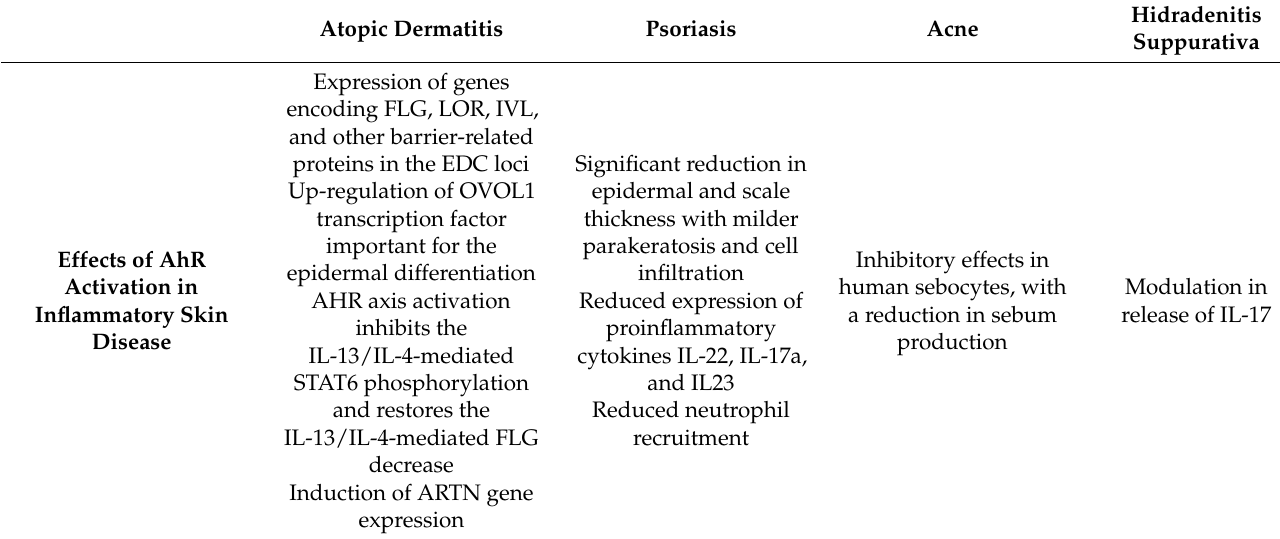
Table 1. Effects of activation of AhR signaling in inflammatory chronic skin